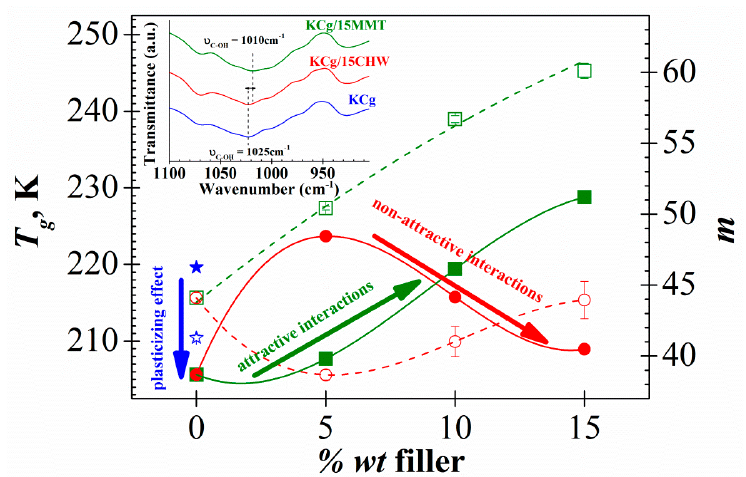
Figure 5. Filler content dependence of the glass transition temperature T g (full symbols) and fragility index m (open symbols) for both KCg / x MMT (square) and KCg / x CHW (cicle) nanocomposites ( x = 0, 5, 10 and 15). Stars correspond to the sample without g (KC). The lines only represent the trend behavior. Inset: FTIR spectra of KCg matrix and KCg / 15MMT and KCg / 15CHW nanocomposites.